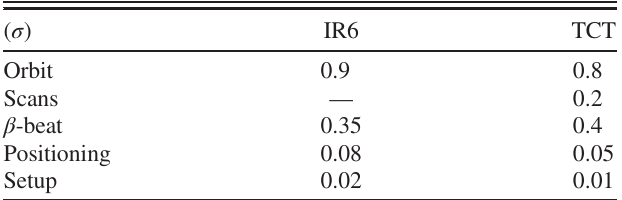
TABLE III. Estimated errors in units of σ at 4 TeV from various sources at the dump protection in IR6 and the TCTs. The 2012 collimator settings were used to estimate the β